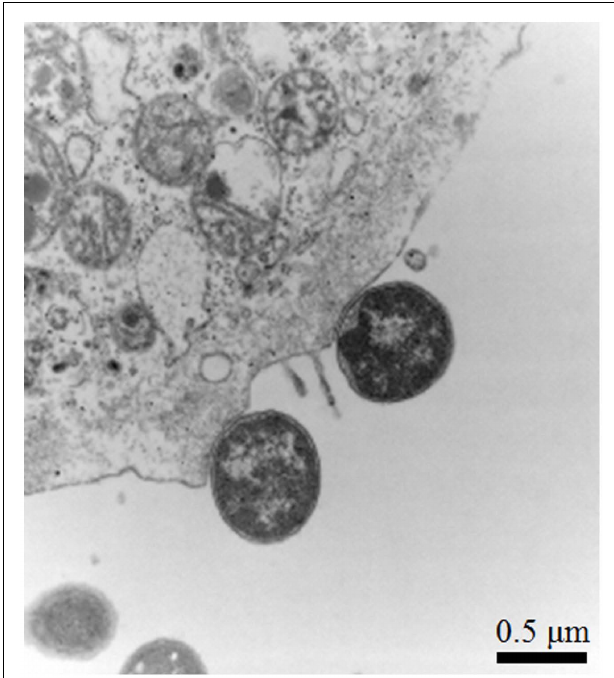
FIGURE 3 | Enterohemorrhagic E. coli intimin can complement a C. rodentium eae mutant forAE lesion formation in vivo . Transmission electron micrograph showing AE pedestal formation on colonic epithelial cells from the distal colon of mice infected with C. rodentium Δ eae/ pInt EHEC . Original magnification, 25,000 × . Bar, 0.5 μ